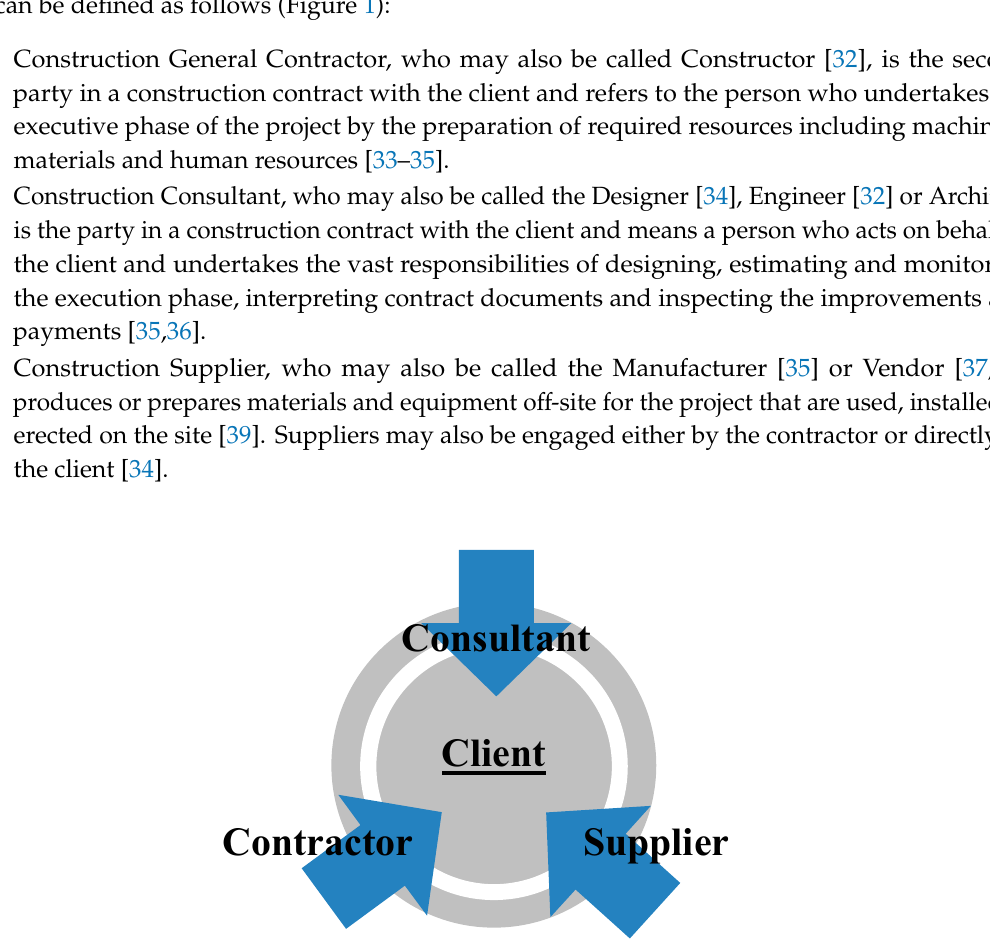
Figure 2. Main steps in source selection. 2.1. Procedures of Source Selection Different countries have developed specific and strict laws and regulations of procurement in the governmental sector for purchasing services or goods [6] especially in construction works, where the public sector is a considerable client [21]. Some countries and organizations may establish a multi-tier system to select a source. For instance, in Taiwan, it is common to consider a two-stage process, which includes prequalification of potential contractors and then selection of the winner through a hard bid [7]. In the UK, although public organizations significantly modify prepared appendices of regulations, they still follow strict procedures [21]. Contractor assignment in the governmental sector of Saudi Arabia is done in a two-